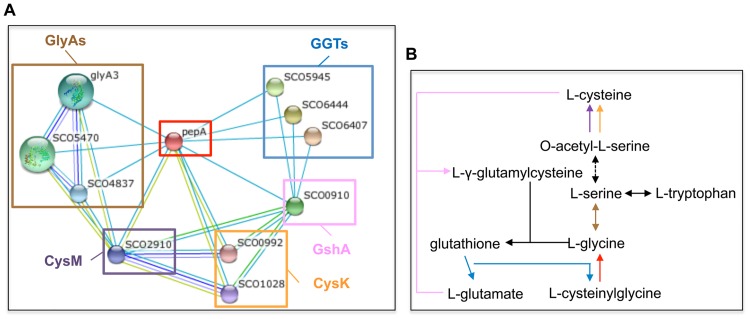
Protein SCO2179 (PepA) association network.(A) STRING interrogation showed PepA association with enzymes involved in amino acid metabolism: glycine hydroxymethyltransferase (GlyA); glutamate-cysteine ligase (GshA); cysteine synthases (CysK and CysM); glutathione hydrolase (GGT). (B) Representation of metabolic circuit involving PepA network partners.